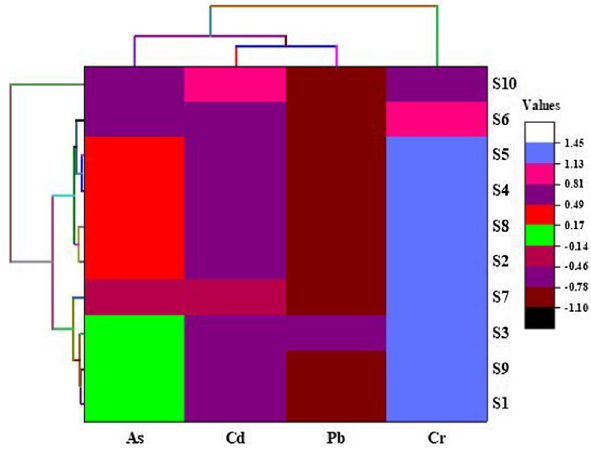
Fig. 3 Two-way hierarchical cluster heat map of the metal concentra- tion along with the sampling sites Table 4 The seasonal and the cumulative pollution load in the study area